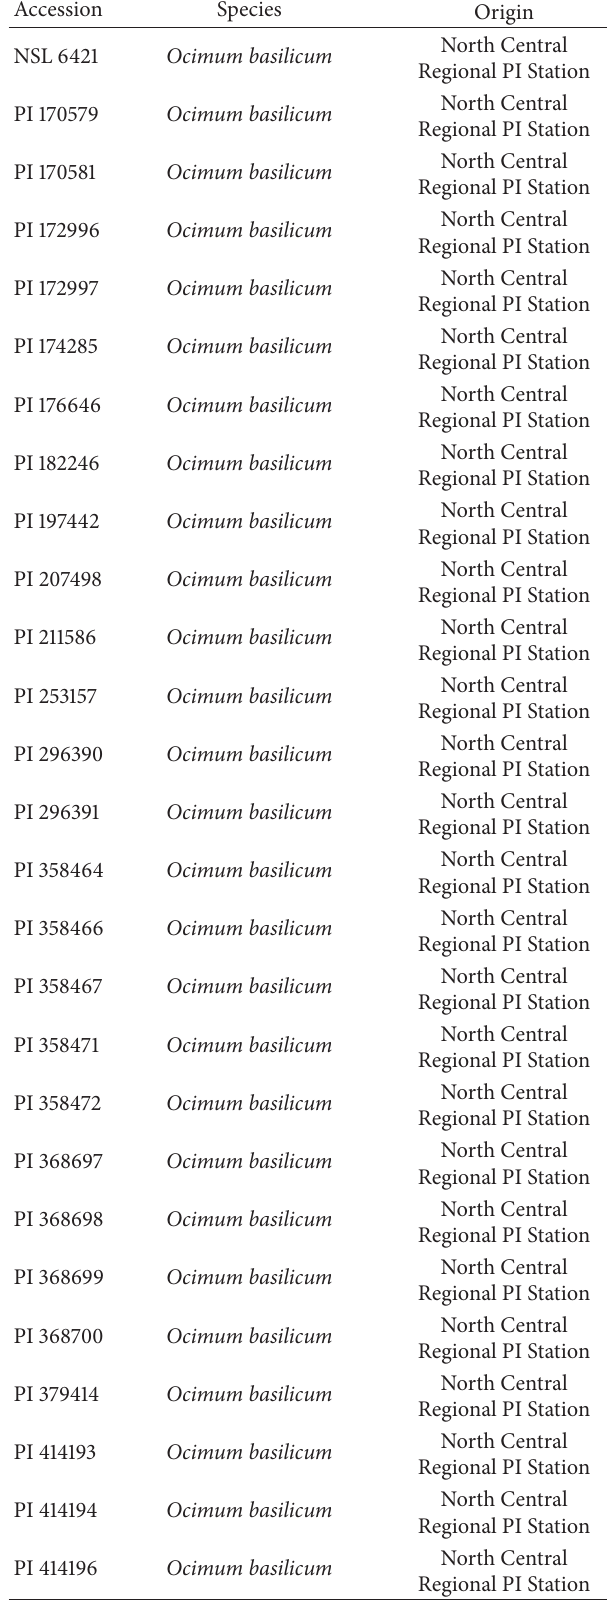
Table 1: Identification and origin of analysed basil accessions and